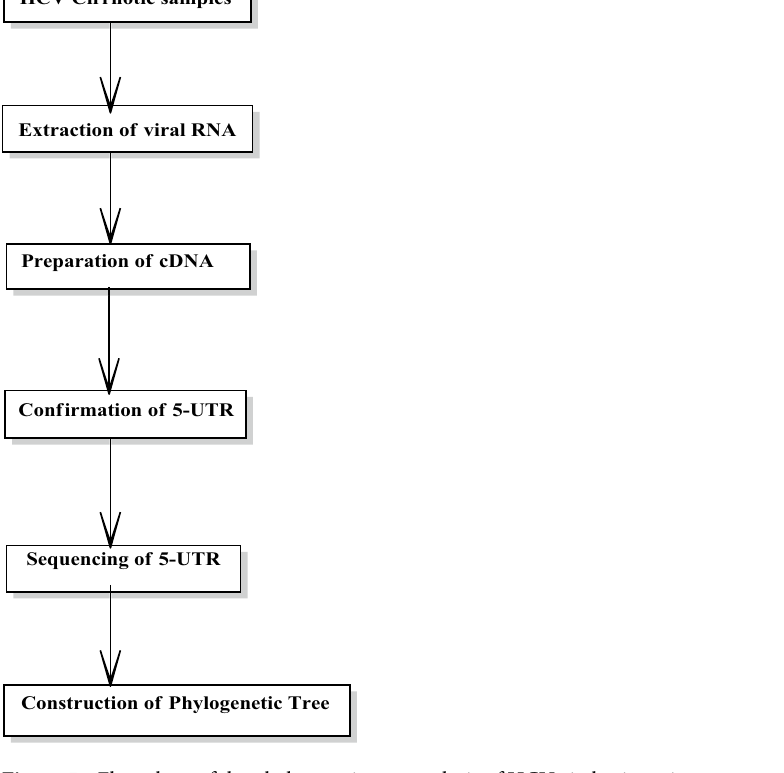
Figure 5. Flow chart of the phylogenetic tree analysis of HCV cirrhotic